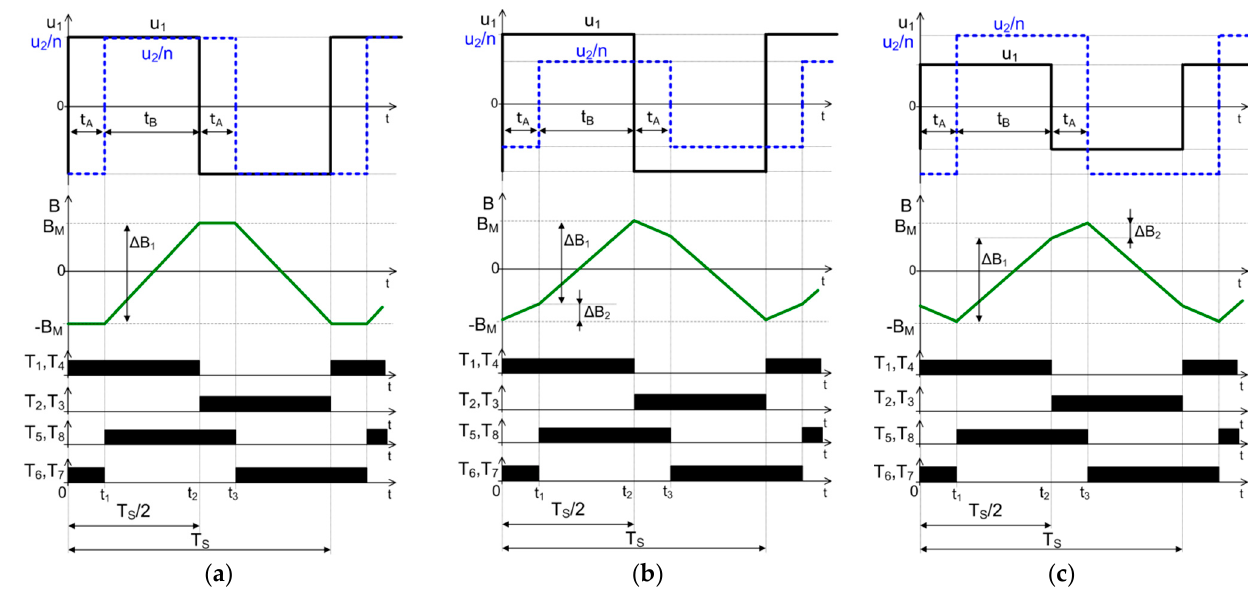
Figure 11. Simplified waveforms of voltages u 1 , u 2 / n and magnetic induction B for ( a ) U DC 1 = U DC 2 / n ; ( b ) U DC 1 > U DC 2 / n; ( c ) U DC 1 < U DC 2 / n.